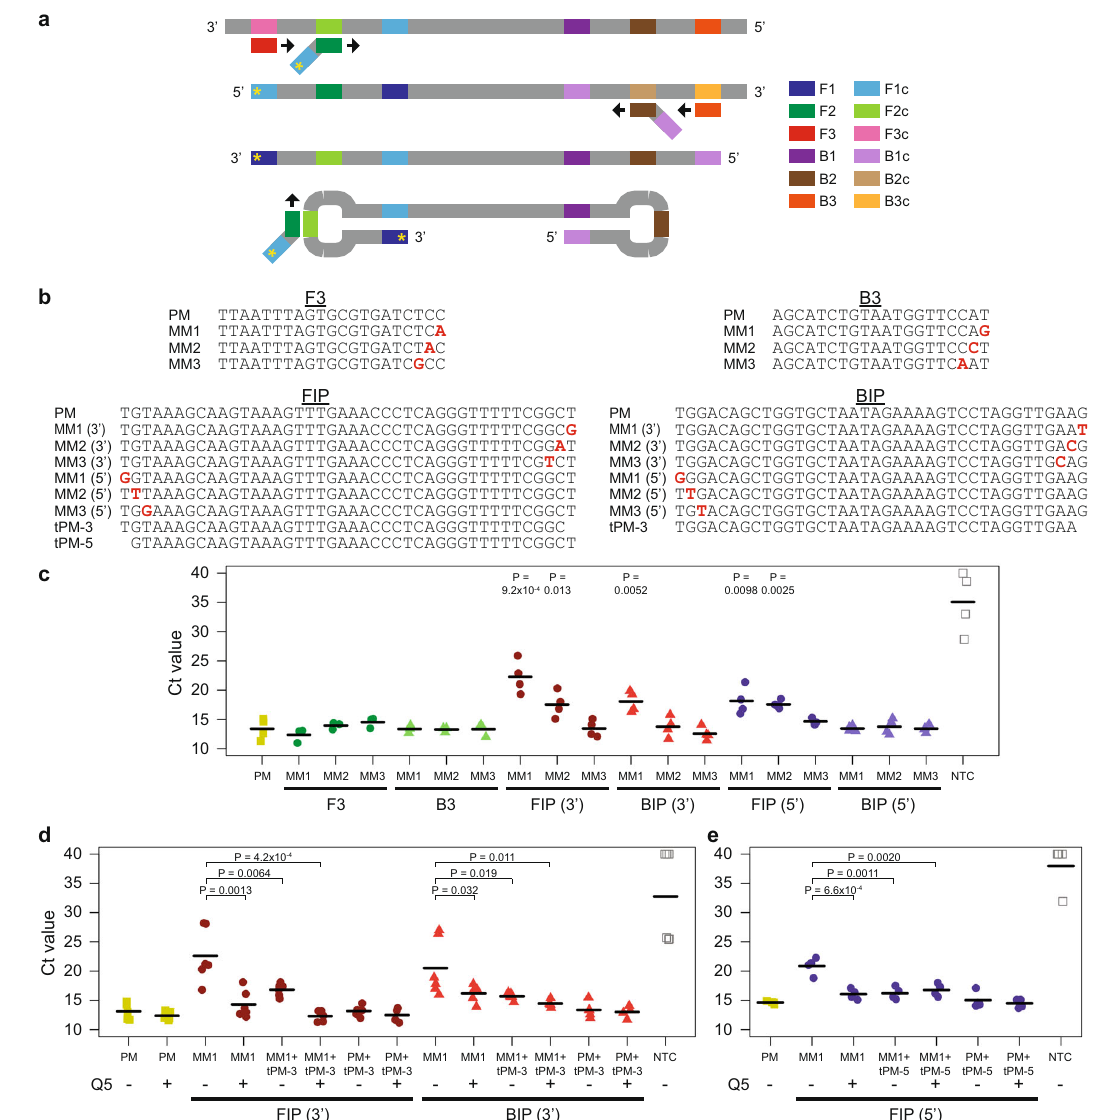
Fig. 3 Evaluating and enhancing the robustness of LAMP. a Schematic of LAMP. Six distinct regions in the target locus (F1, F2, F3, B1, B2, and B3) are recognized by four core primers, which have a black arrow at their 3 ’ ends to represent extension by the DNA polymerase. FIP is represented by a dark green rectangle joined to a slanted light blue rectangle. BIP is represented by a dark brown rectangle joined to a slanted light purple rectangle. In addition, the F3 displacement primer is represented by a red rectangle, while the B3 displacement primer is represented by an orange rectangle. The letter “ c ” appended to each region name indicates the reverse complementary sequence. After our LAMP optimization process, we incorporated swarm primers, whose sequences are equivalent to F1c and B1c. Moreover, to demonstrate how a mismatch at the 5 ’ end of FIP can affect the LAMP reaction, we have added a yellow asterisk to track the progression of the mismatch. b Sequences of LAMP primers tested. The mismatches are indicated by bold red letters. c Strip chart showing how mismatches between LAMP primers and their binding sites affected the rate of isothermal ampli fi cation. RT-LAMP was performed at 65 °C in a real-time instrument with 20,000 copies of synthetic RNA corresponding to the S-gene of SARS-CoV-2. Cycle-threshold (Ct) values were given by the instrument using default settings. The black horizontal bars among the data points in the strip chart represent the mean ( n = 3 [F3 MM, B3 MM] or 4 [PM, FIP (3 ’ ) MM, BIP (3 ’ ) MM, FIP (5 ’ ) MM, BIP (5 ’ ) MM, NTC] biological replicates). P -values were calculated using one-sided Student ’ s t -test. d Strip chart showing rescue of the LAMP reaction by truncated primers and a Q5 high- fi delity DNA polymerase in the presence of mismatches at the 3 ’ ends of FIP and BIP. RT-LAMP was performed at 65 °C with 20,000 copies of RNA template. The black horizontal bars among the data points in the strip chart represent the mean ( n = 4 [FIP PM + tPM + Q5, BIP PM + tPM + Q5], 5 [PM, PM + Q5, FIP MM + tPM + Q5, FIP PM + tPM, BIP MM + tPM + Q5, BIP PM + tPM], or 6 [FIP MM, FIP MM + Q5, FIP MM + tPM, BIP MM, BIP MM + Q5, BIP MM + tPM, NTC] biological replicates). P -values were calculated using one-sided Student ’ s t -test. e Strip chart showing rescue of the LAMP reaction by truncated primers and a Q5 high- fi delity DNA polymerase in the presence of a mismatch at the 5 ’ end of FIP. RT-LAMP was performed at 65 °C with 20,000 copies of RNA template. The black horizontal bars among the data points in the strip chart represent the mean ( n = 4 biological replicates). P -values were calculated using one-sided Student ’ s t -test. Source data are available in the Source Data fi